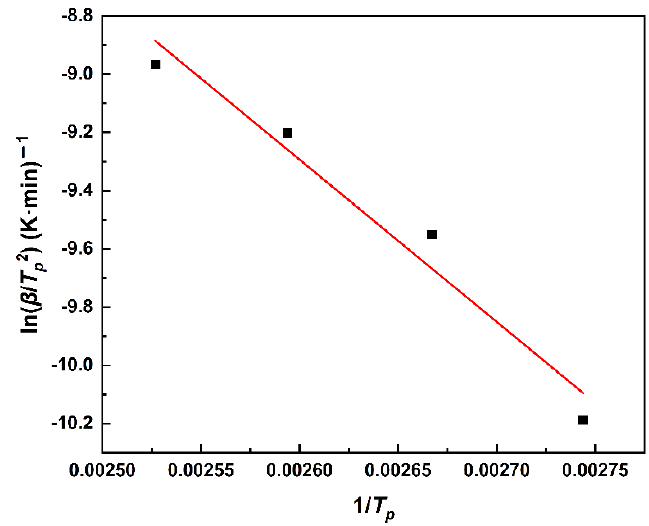
Figure 3. The linear fit of ln β / T p2 and1/ T p by the Kissinger method.